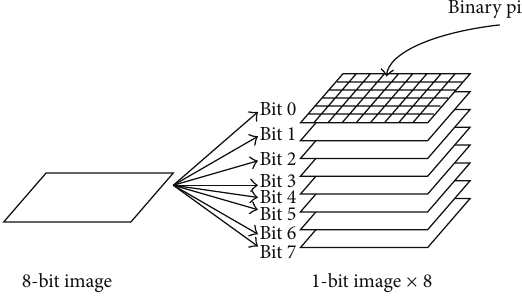
Figure 1: Binary pixel blocks on